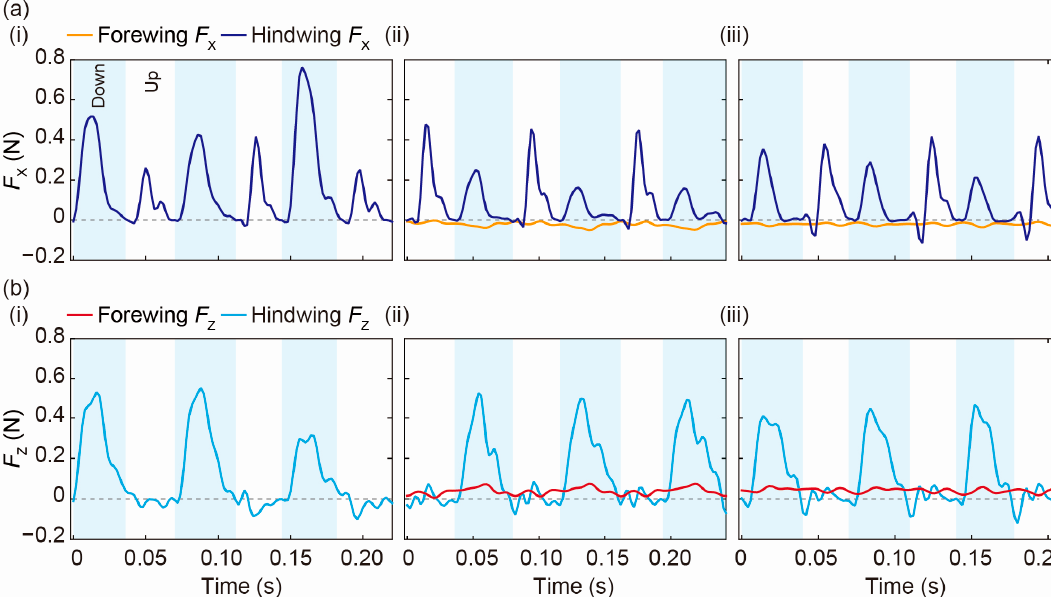
Figure 7. ( a , b ) Calculated F X and F Z of the forewing and hindwing from the measured differential pressure, wing area, body angle, flapping angle and feathering angle ( i ) without a forewing ( ii ) with a flapping forewing and ( iii ) with a fixed forewing.